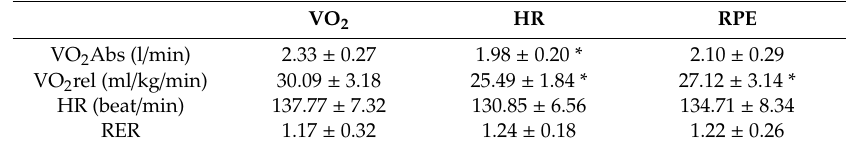
Table 2. Means and standard deviations of absolute (VO 2 Abs) and relative (VO 2 rel) oxygen uptake, heart rate (HR), and respiratory exchange ratio (RER) in the three sessions.